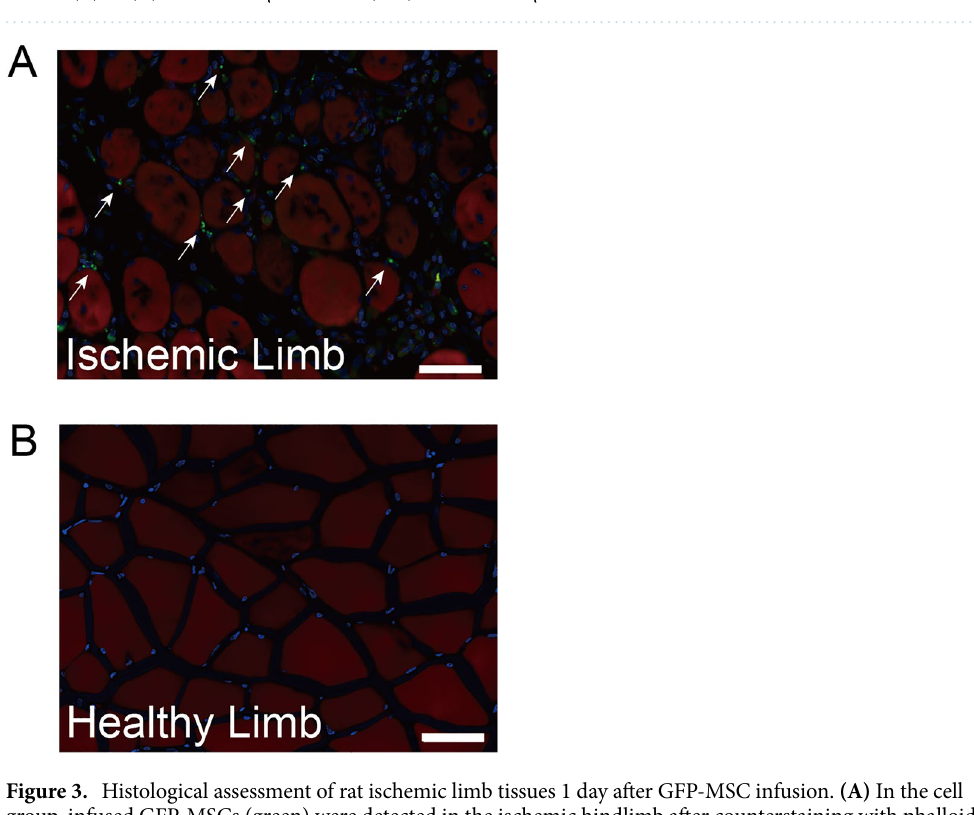
Figure 2. Histological assessment of ischemic hindlimb muscle. (A) Capillary vessel density. (B,C) Immunostaining of capillary vessels with anti-vWF (brown) and nuclei (blue). (D) Red arrows indicate capillary vessels. (E) Quantification of muscular atrophy. (F,G) Muscle fibers stained with hematoxylin and eosin. Scale bars in (B) to (C) indicate 50 μm, and in (F,G) indicate 100 μm.